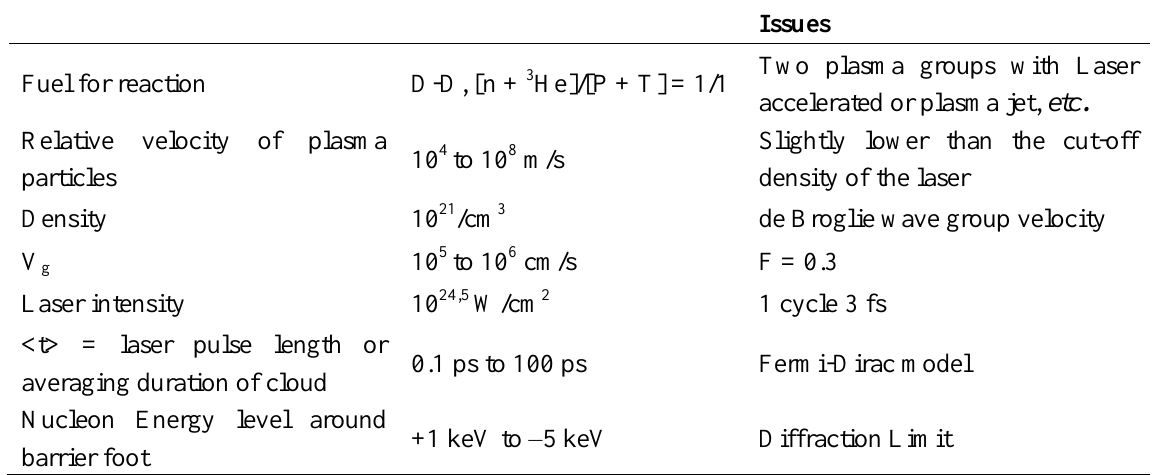
Table 2. Reaction parameters for gain in Deuteron